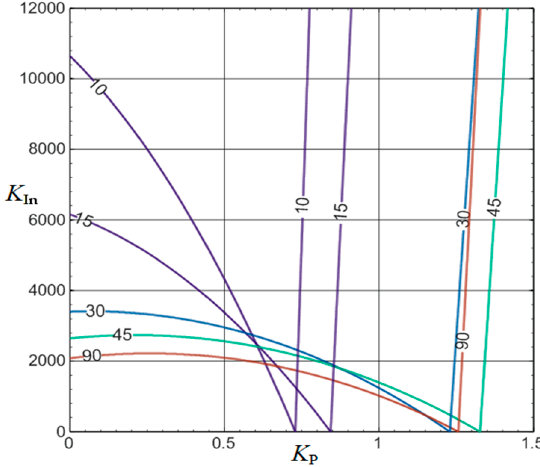
Figure 15. Evaluation of the stability region in the K P - K In plane for the nominal case.